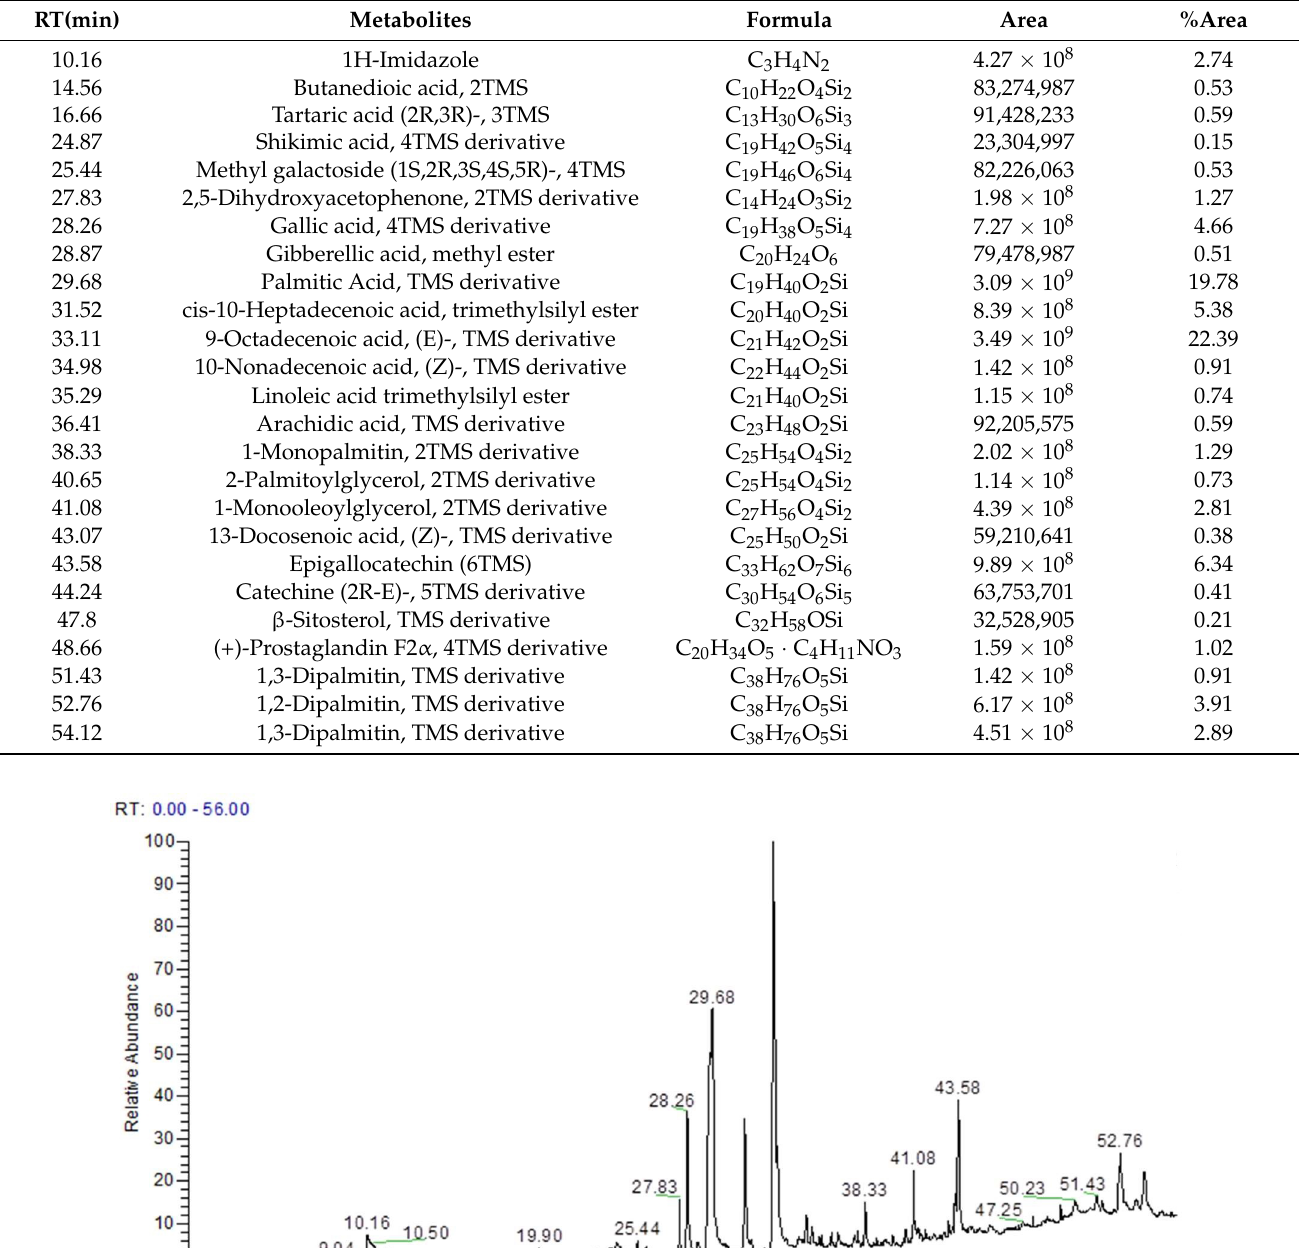
Table 1. Phytocompounds identified in bioactive fraction of A. acuminata leaf extract.